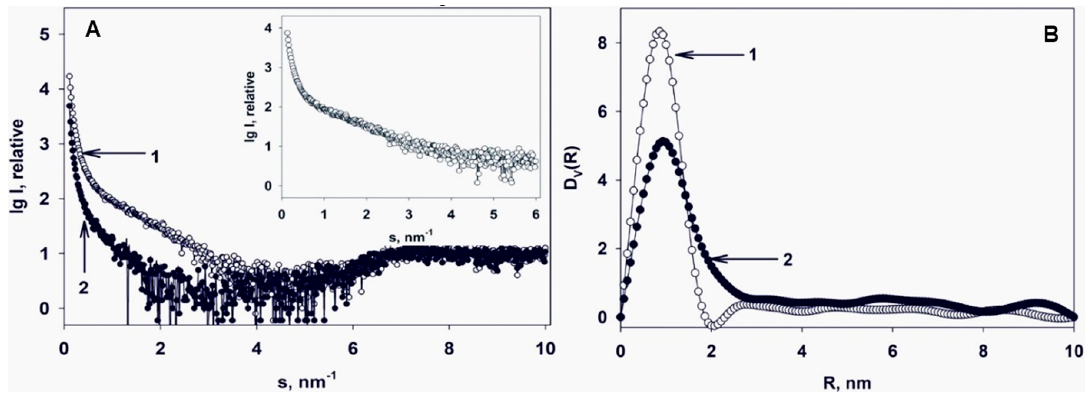
Figure 4. ( A ) Experimental (SAXS) curves: 1—Cu-carrying chitosan; 2—pristine non-modified chitosan (chitosan low molecular weight (ChitLMW)). Insert—difference SAXS curve for the embedded Cu nanoparticles. ( B ) Volume size distribution functions D V (R) : 1—Cu nanoparticles; 2—pristine non-modified chitosan (ChitLMW).